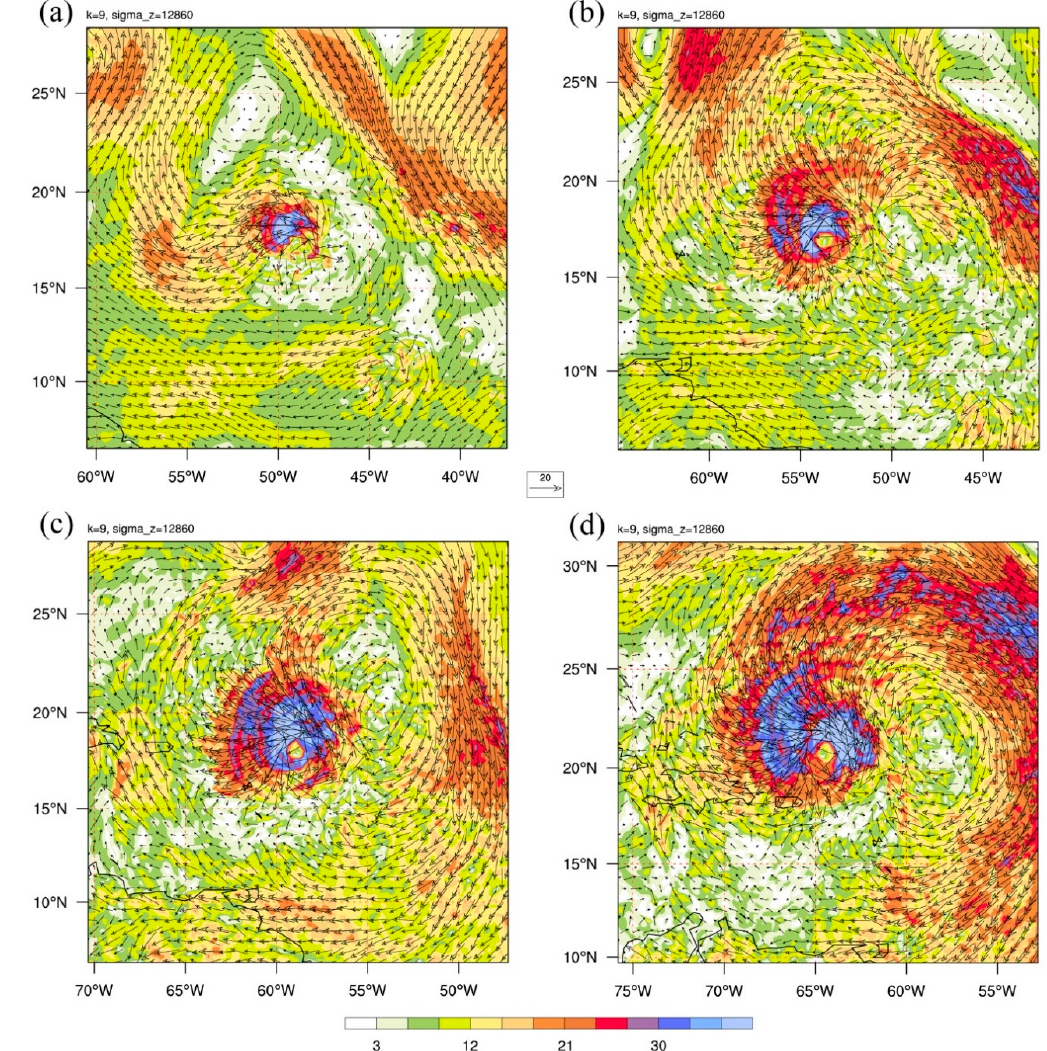
Figure 11. ( a ) Warm-start initial conditions (tau = 0 h) z = 12,860 m wind vectors (m s − 1 ; color bar and 20 m s − 1 length indicated by arrow in middle) at 1800 UTC 3 September from the 15 min AMV FCDI analysis as in Figure 6d, and COAMPS-TC forecasts at ( b ) tau + 24 h, ( c ) tau + 48 h, and ( d ) tau + 72 h.